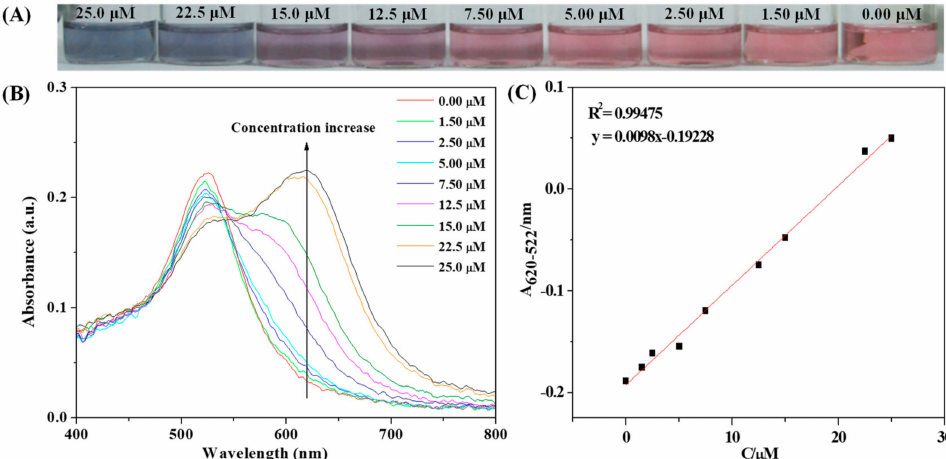
Figure 7. Sensitivity of AuNP probe (0.798 nM): ( A ) photographs and ( B ) absorption spectra of distilled water samples containing di ff erent concentration of creatinine (from 0 to 25 µ M). The ( C ) linear relationship between creatinine concentration and absorbance response in distilled water